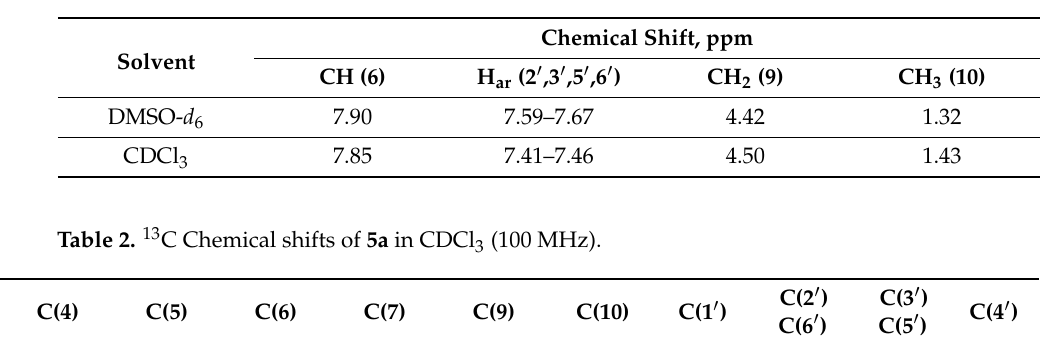
Table 1. 1 H Chemical shifts of 5a in DMSO- d 6 and CDCl 3 at 400 MHz.